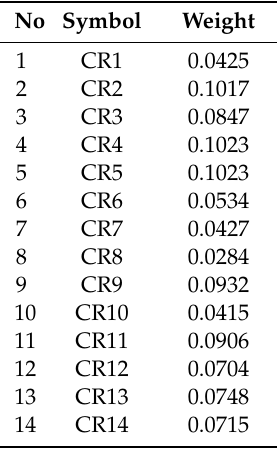
Table 4. The weights of criteria.